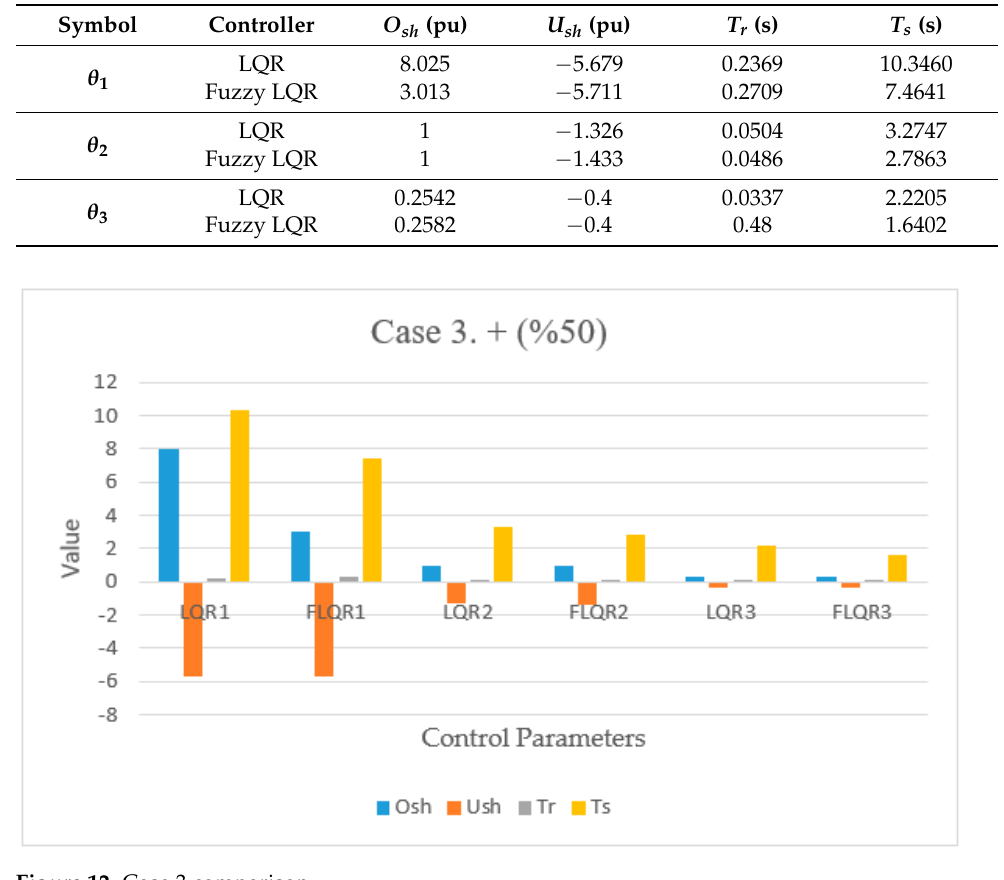
Figure 12. Case 3 comparison.